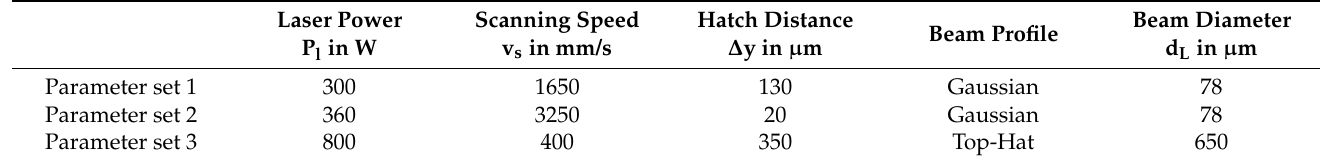
Table 2. Used parameters.